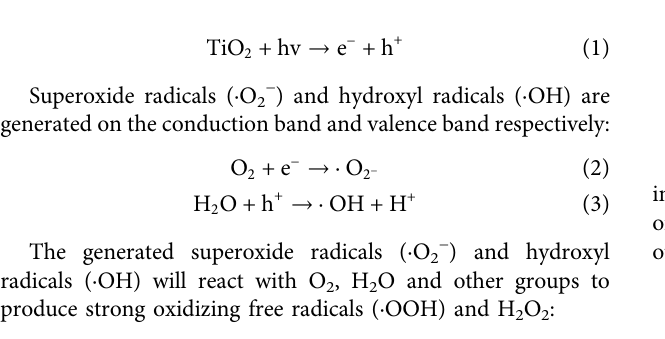
Frontiers in Catalysis |